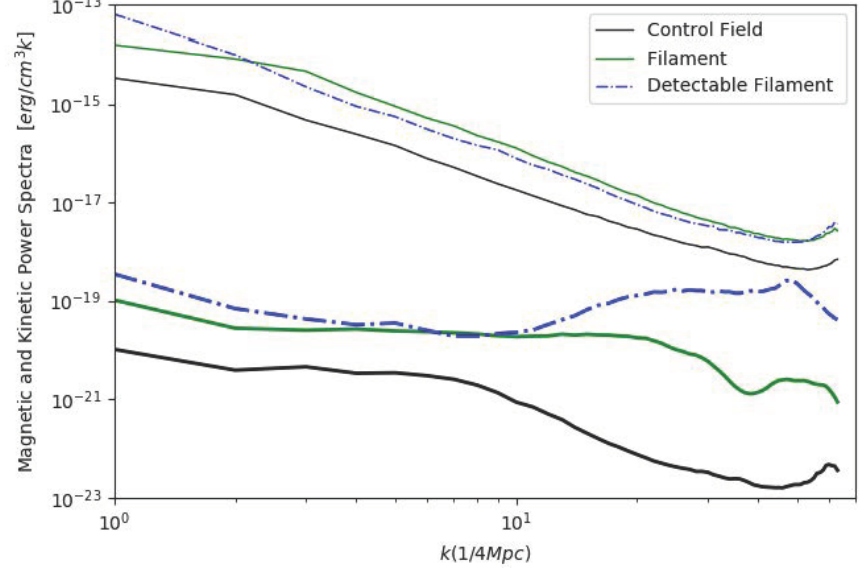
Figure 5. The upper thin lines show the 3-dimensional power spectra for the density weighted velocity field ( ρ 1/2 v ) and the lower thick lines show the 3-dimensional magnetic power spectra in three sub-volumes of the cluster